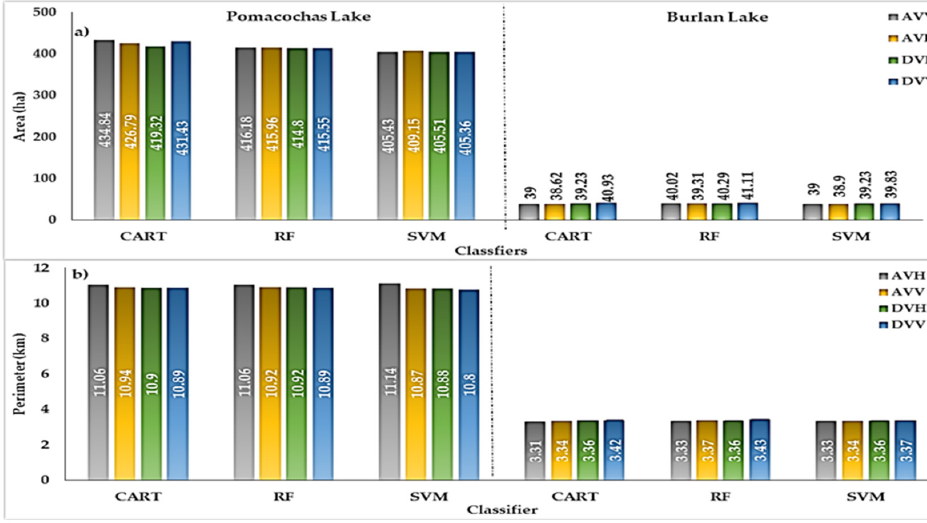
Figure 6. Average values of the ( a ) area and ( b ) perimeter of Pomacochas and Burlan Lakes.